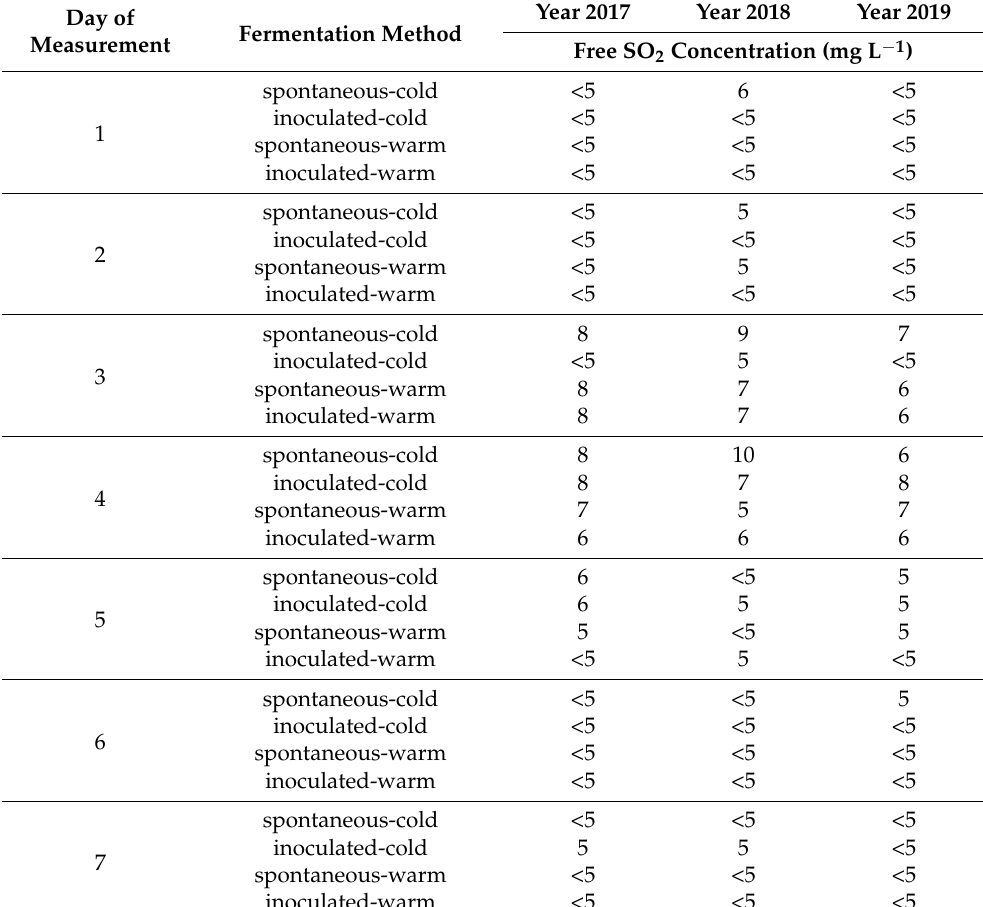
Table 2. Changes in the free sulphur dioxide content (mg L − 1 ) during storage in three vintages (2017, 2018, 2019) (LOD of the method: 5 mg L − 1